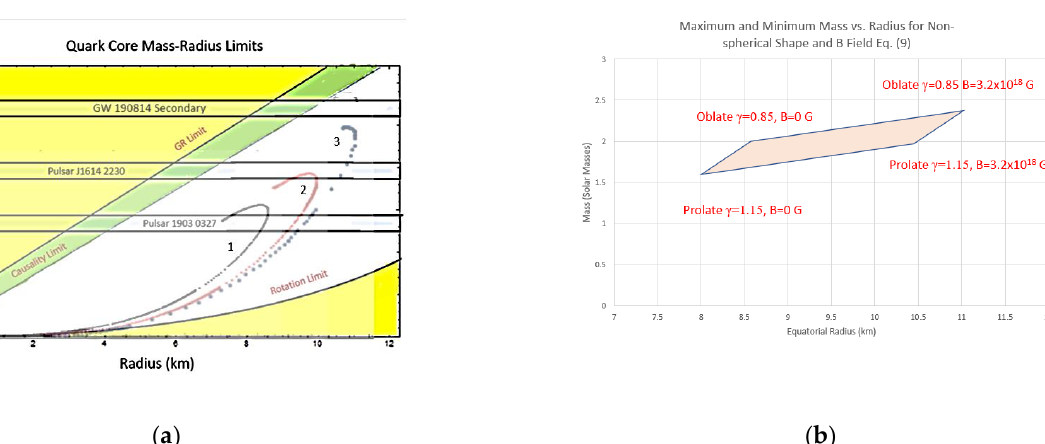
Figure 2. ( a ) Quark core mass vs. equatorial radius relation from the TOV equations for an oblate deformation, γ =0.85, and a magnetic field, B = 3.2 × 10 18 G, designated as case (1), for no deformation, γ = 1, with a magnetic field, B = 3.2 × 10 18 G, designated as case (2), prolate γ = 1.15 with a magnetic field designated as case (3) and, in ( b ), the change in the mass and equatorial radius of the core is displayed for the range of deformation values from an oblate ( γ = 0.85) to prolate ( γ = 1.15) shape and the magnetic field range from B = 0 G to B = 3.2 × 10 18 G for near the middle of the stability window at B = 57 MeV/fm 3 .